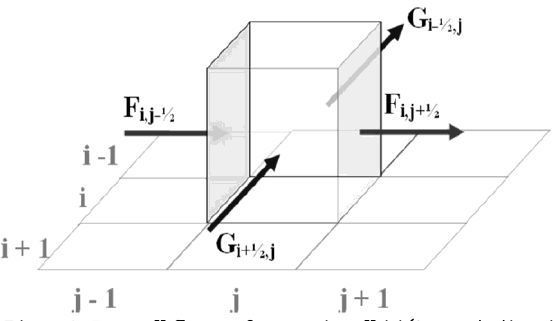
Figure 3. Intercell fluxes of a generic cell i,j (G=north direction fluxes, F=East direction fluxes)